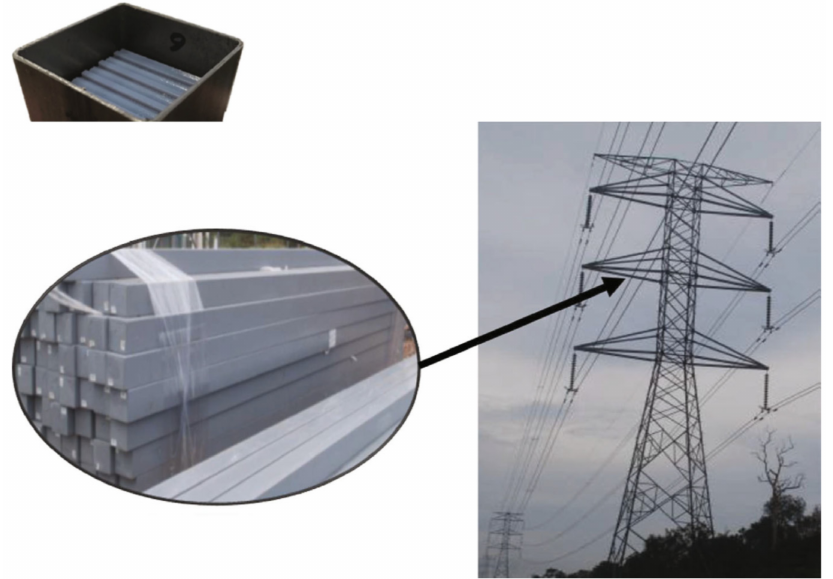
Figure 15. Innovation of honeycomb-filled structure configuration, which potentially can be used in